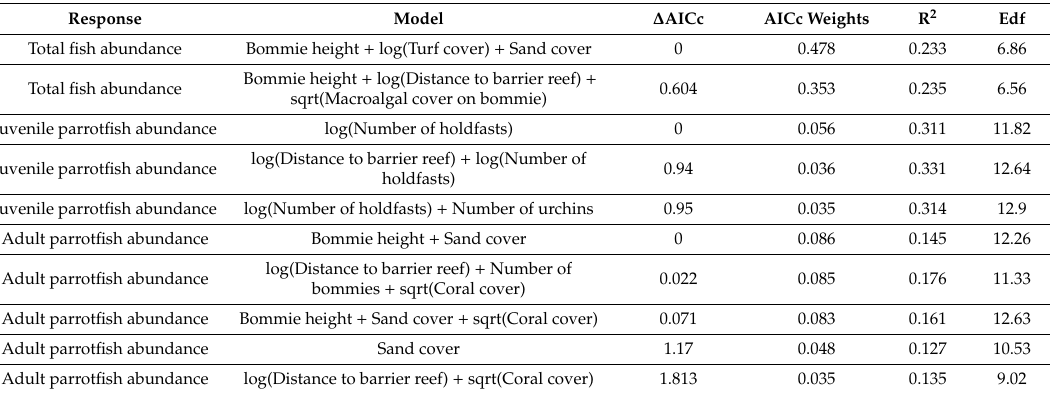
Table 3. Most parsimonious models explaining spatial variation in total fish and parrotfish (adult and juvenile) abundance. Results based on generalized additive model (GAM) and full subset models. All models with ∆ AICc < 2 are